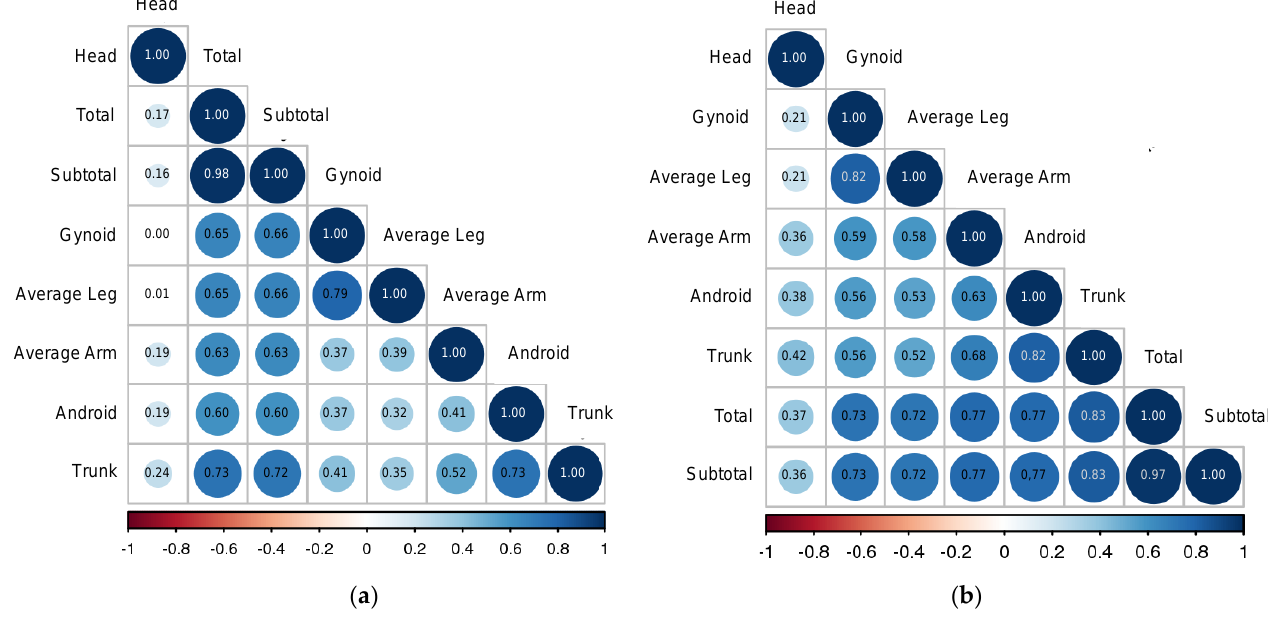
Figure 4. Correlation matrix of Fat Distribution in Obese ( a ) Female NAFLD ( b ) Male NAFLD. As can be seen from Table 5, the multivariate logistic regression model presented a consistent trend of rising body fat percentages being associated with increased odds of NAFLD development in obese individuals. The Q4 of percent trunk fat was associated with the highest odds of NAFLD development for both non-obese (OR: 46.61, 95%CI: 33.55 – 64.76, p < 0.001) and obese individuals (OR: 2.93, 95%CI: 2.07 – 4.15, p < 0.001) relative to their respective Q1 of body fat distribution. From the marginal model (Table 5), obese